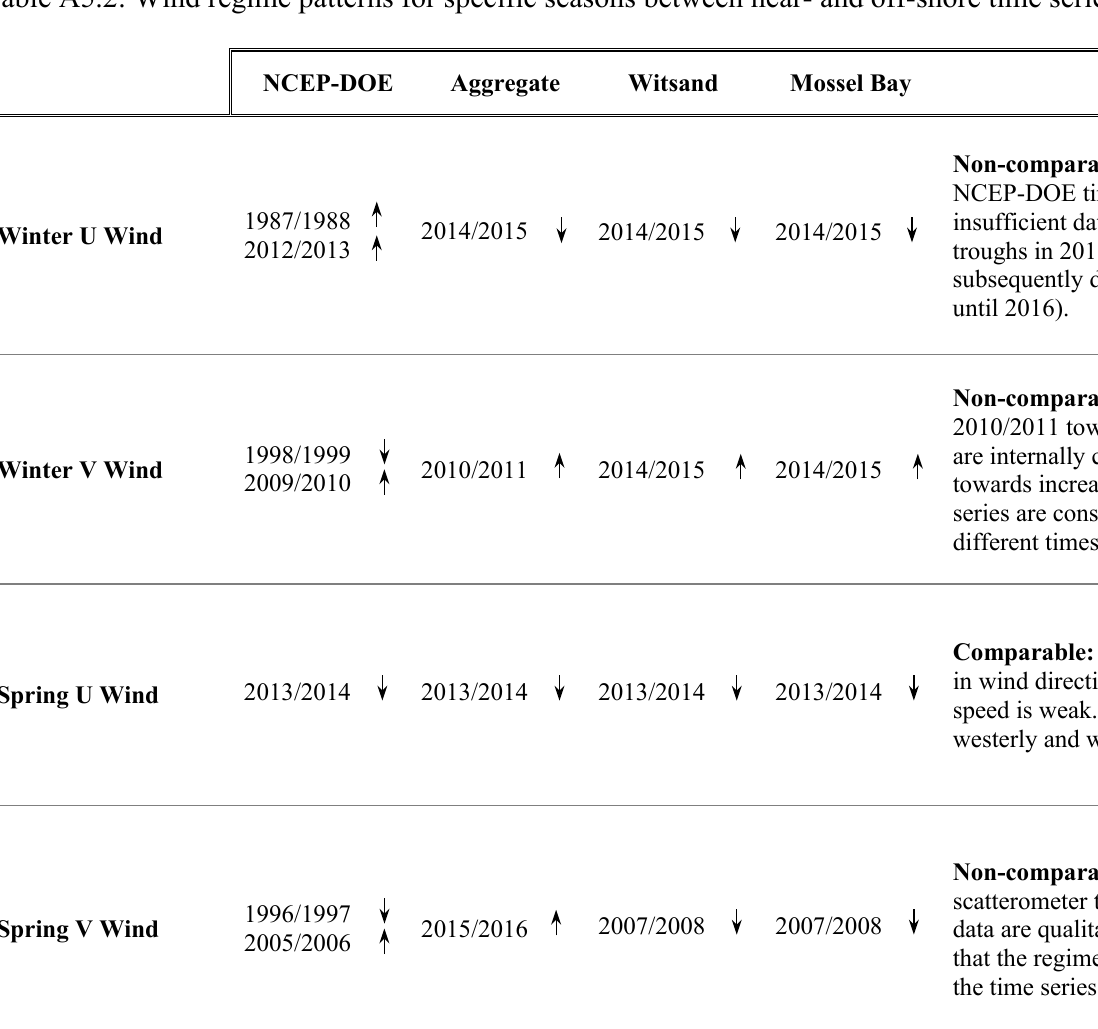
Table A5.2: Wind regime patterns for specific seasons between near- and off-shore time series analysing the